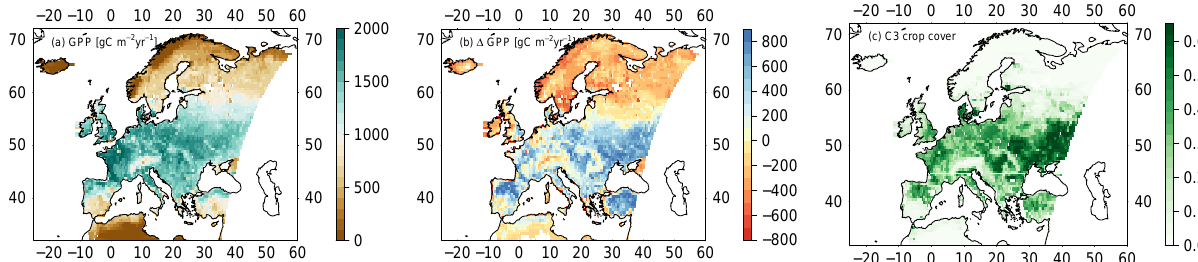
Figure 5. Europe-wide simulated GPP and difference between modelled GPP by OCN and a GPP estimate by a FLUXNET-MTE product. Plotted, for the years 1982–2011, are (a) the simulated mean GPP accounting for ozone damage in gCm − 2 yr − 1 , (b) the mean differences for OCN minus MTE GPP in gCm − 2 yr − 1 , and (c) the mean simulated grid cell cover of the C 3 -crop PFT in OCN, given as fractions of the total grid cell area.